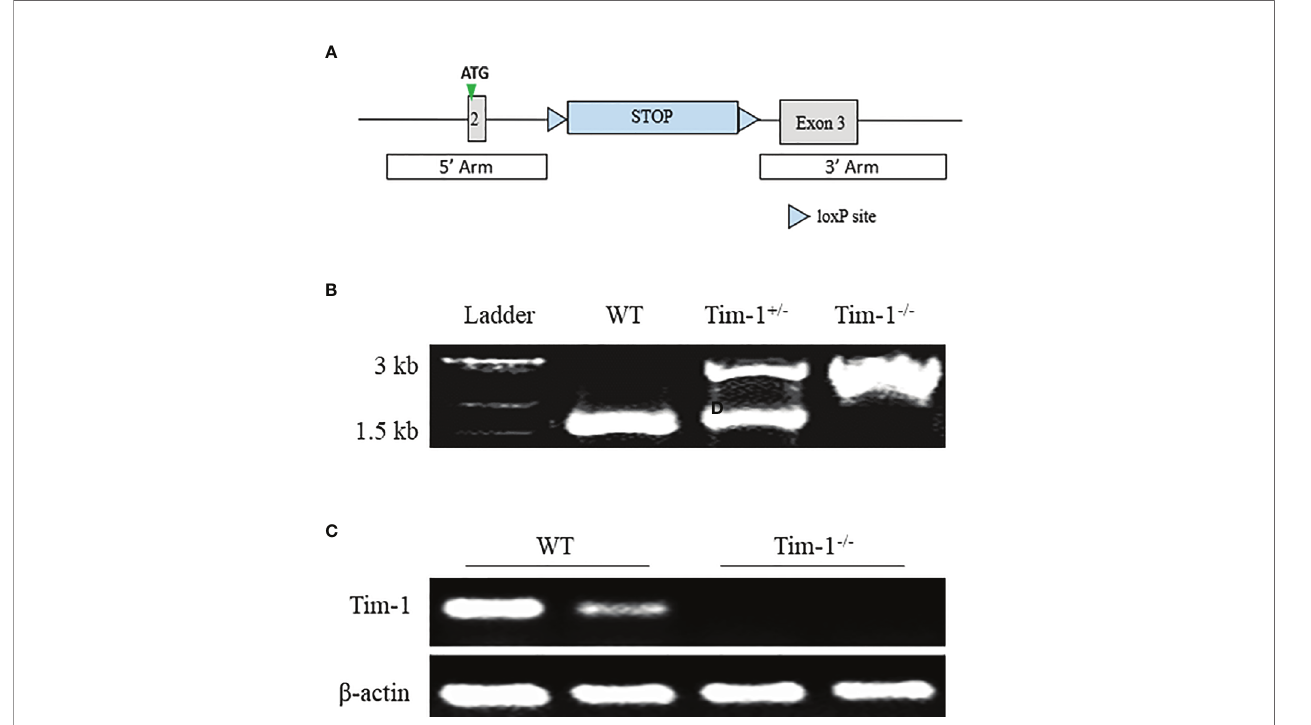
FIGURE 2 | Generation of global Tim-1 knockout mice. (A) Schematic diagram of generation of Tim-1 Lox-Stop-Lox knock-in (Tim-1 -/- ) mice. (B) Genotyping PCR of tail DNA from wild-type (WT), heterozygous (Tim-1 +/- ), and homozygous (Tim-1 -/- ) mice. (C) Representative image of hepatic Tim-1 gene after 35 cycles RT-PCR in WT and Tim-1 -/-